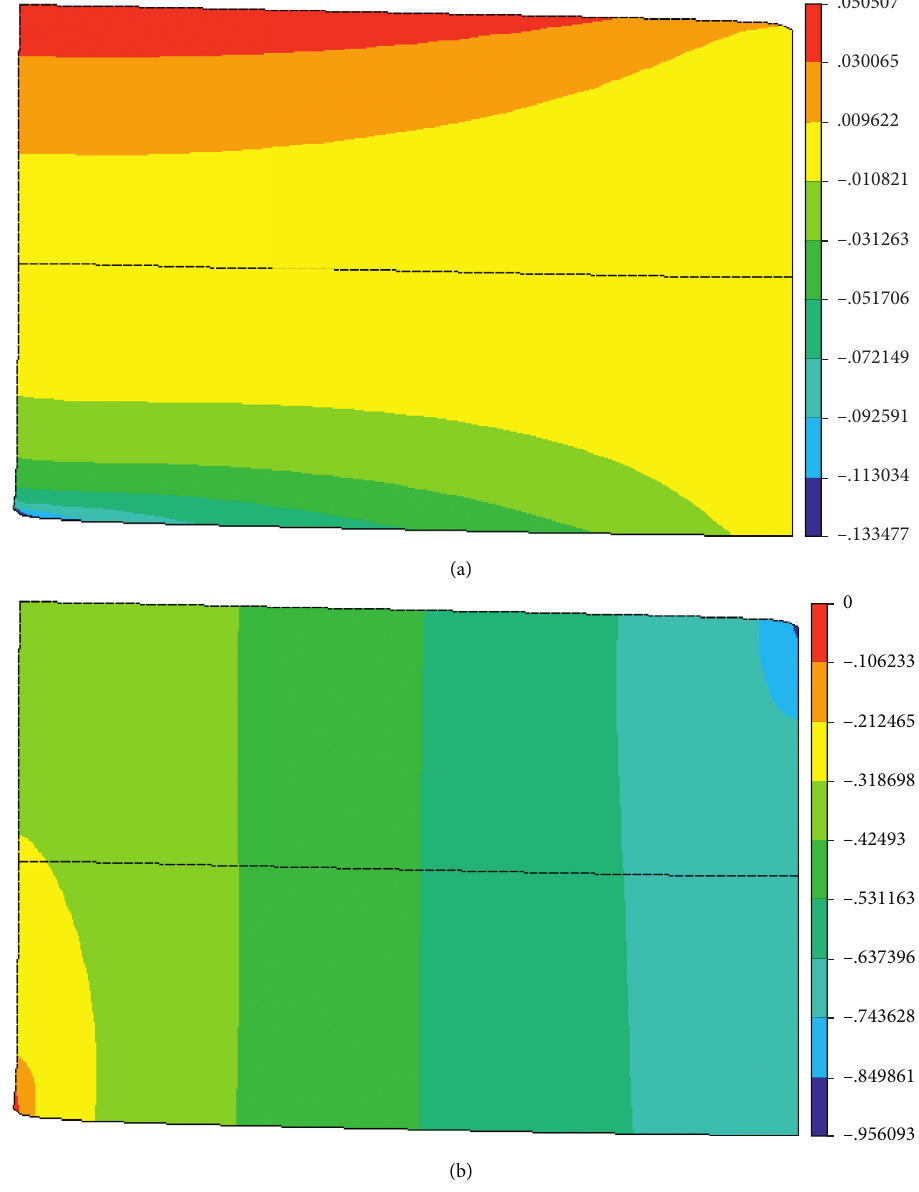
Figure 2: Displacement distributions of heterogeneous orthotropic bimaterials: (a) u